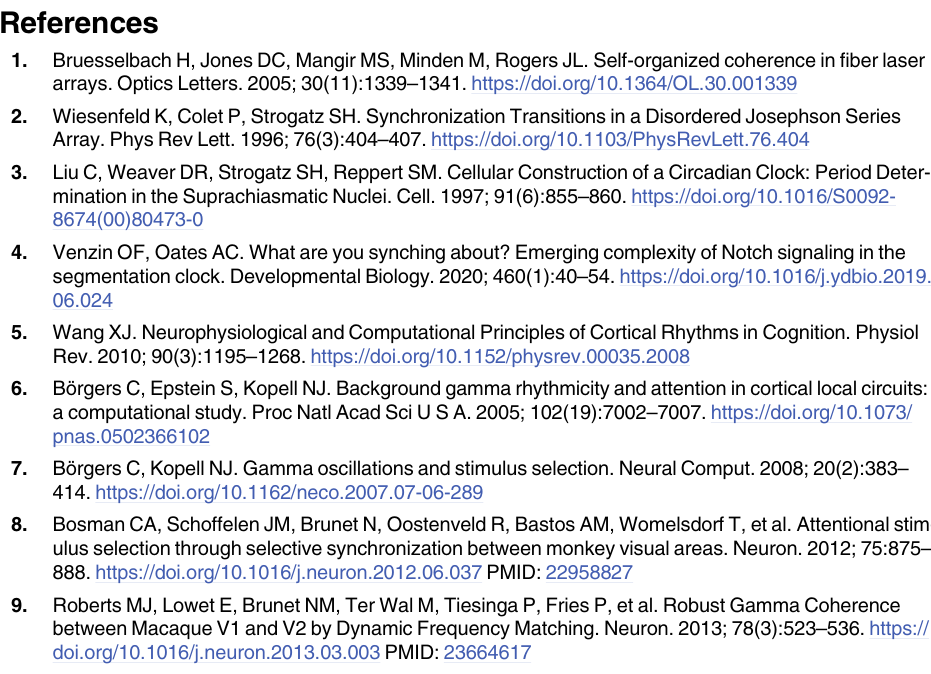
S3 Fig. Subharmonic response of the ING rhythm with a longer synaptic delay within the network ( τ = 5 ms) receiving periodic inhibitory input. For each value of the input hetero- d geneity, the natural frequency f was kept constant ( f = 44 Hz) by adjusting the network network mean input strength I ( I ) . The range of detuning where increasing heterogeneity induced a type 3 synchronization became wider compared to Fig 6B, where τ = 3 ms. W ( ext ) = 1.2 × 10 − 3 . d